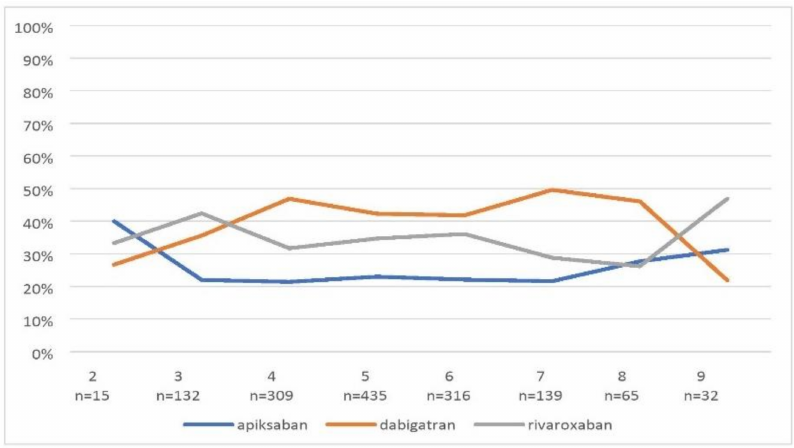
Figure 4. Division into individual NOACs depending on the CHA 2 DS 2 - VASc score. The mean HAS-BLED score was 2.2 ± 0.8 points. The result of ≥ 3 points was obtained by 466 (32.3%) people; moreover, higher values of the HAS-BLED score